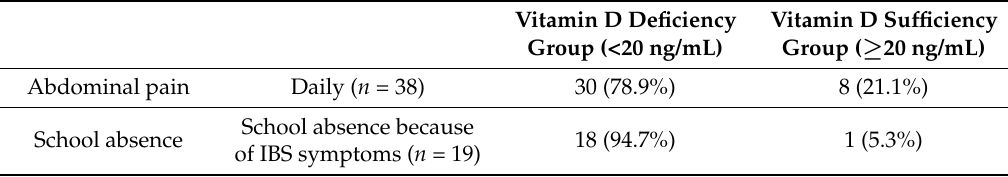
Table 2. Association of vitamin deficiency and sufficiency with abdominal pain and school